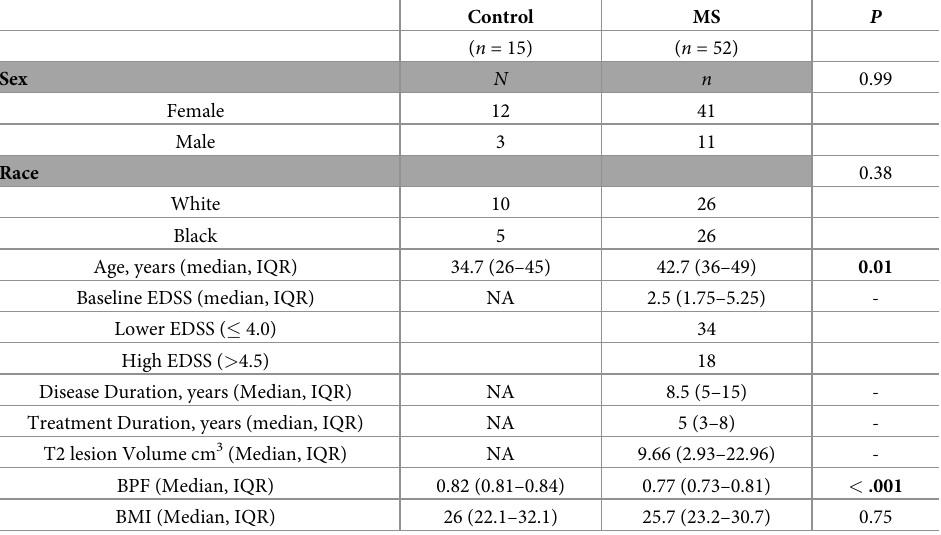
Table 1. Baseline demographic, clinical, and MRI characteristics of subjects.